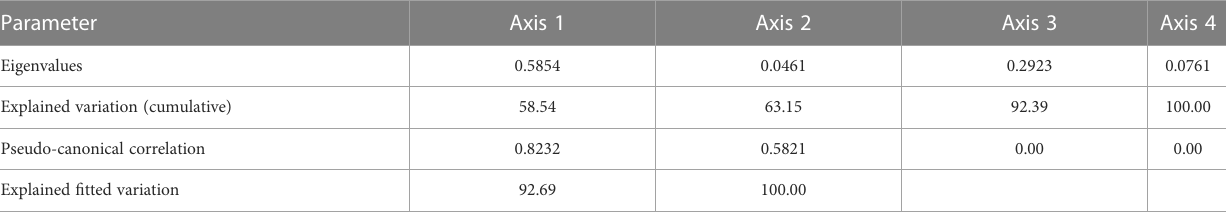
TABLE 2 Summary of the parameters of the Redundancy Analysis (RDA).